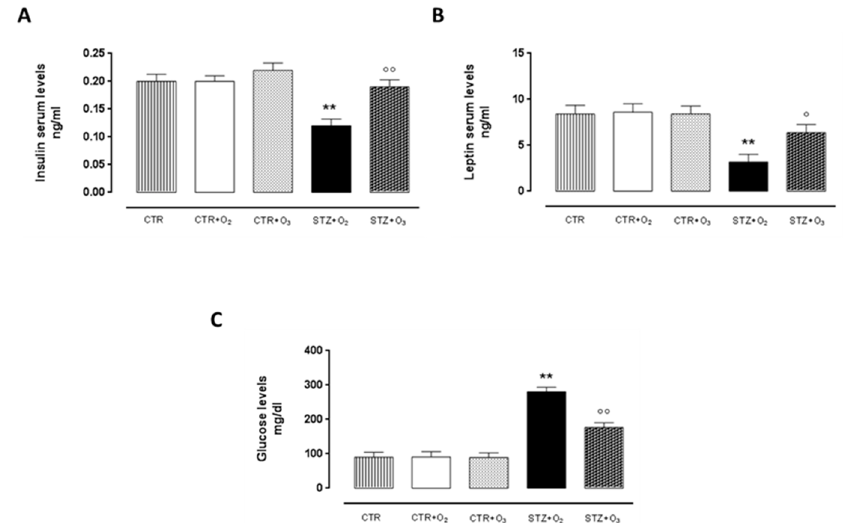
Figure 8. Insulin, leptin and glycemia levels. ELISA test results of insulin and leptin serum levels (mg/dl ± s.e.m.), one week after STZ. Ozone treatment significantly increased insulin and leptin levels, that were low in STZ rats. Ozone treatment significantly reduced the high glycemia levels in STZ rats ( p < 0.01). CTR = saline-treated rats; CTR + O 2 = oxygen-treated rats; CTR + O 3 = ozone-treated rats; STZ + O 2 = oxygen-treated STZ rats; STZ + O 3 = ozone-treated STZ rats. ** p < 0.01 vs. CTR + O 2 ; ° p < 0.05 vs. STZ + O 2 ; °° p < 0.01 vs. STZ + O 2 .